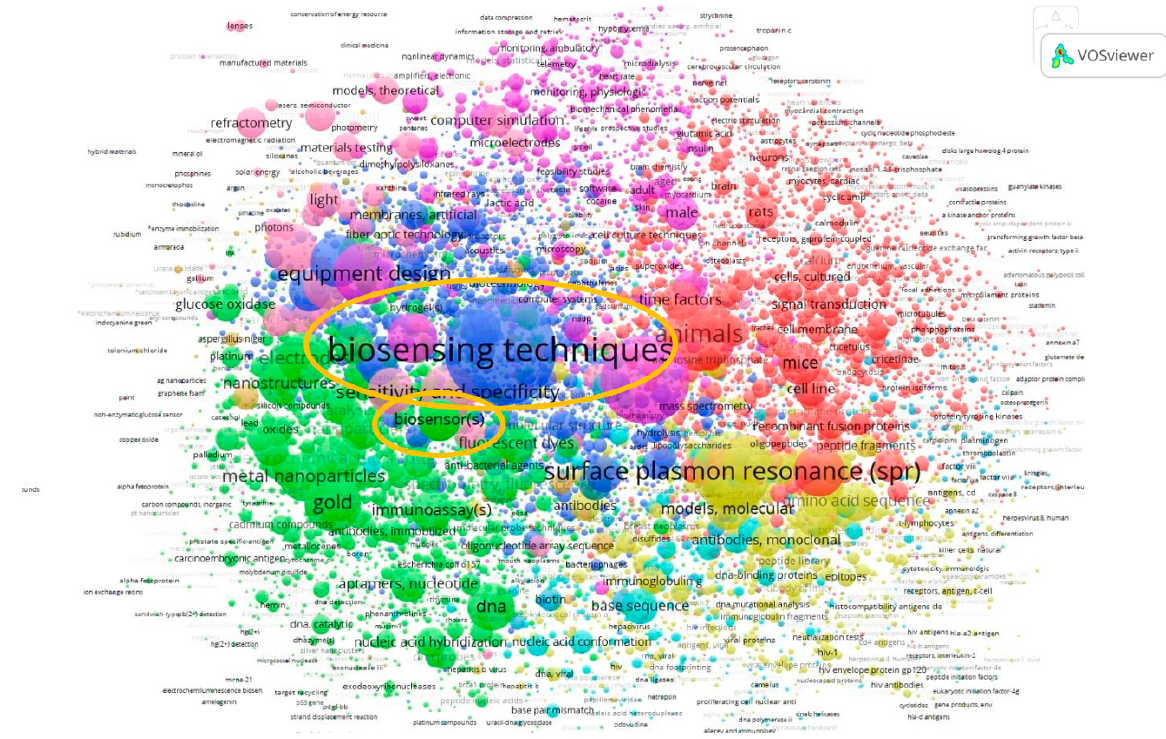
Figure 19. Co-occurrence analysis of All Keywords.